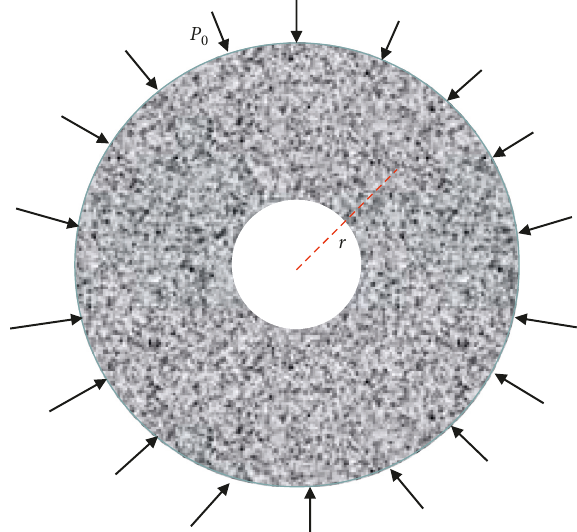
Figure 3: Mechanical model after tunnel